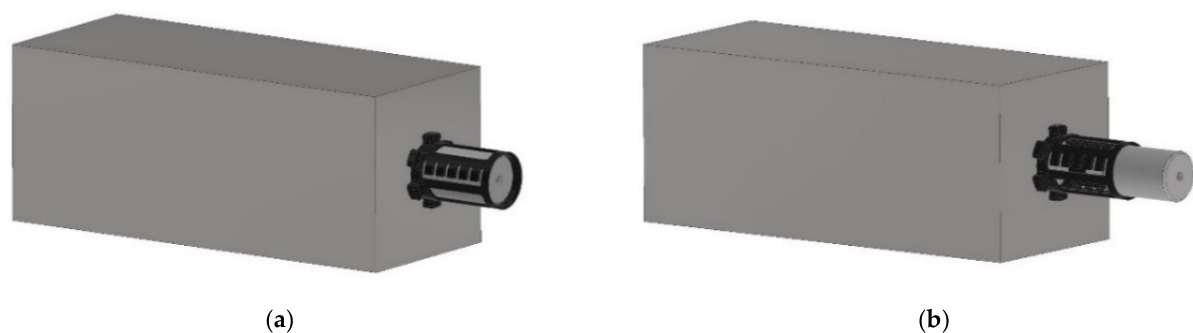
Figure 3. View of two variants of shaped charges: ( a ) charge closest to the target and ( b ) charge farthest from the target.